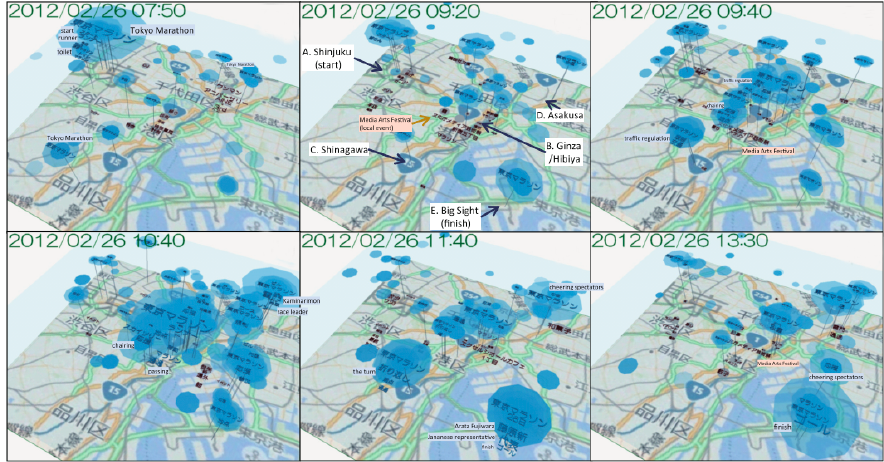
Figure 7. Multilayered spatial word-cloud visualization of the Tokyo Marathon on 26 February 2012 [24].